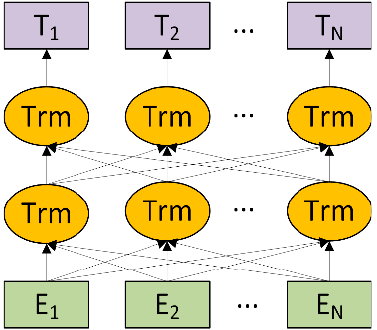
Figure 3. The overall architecture of